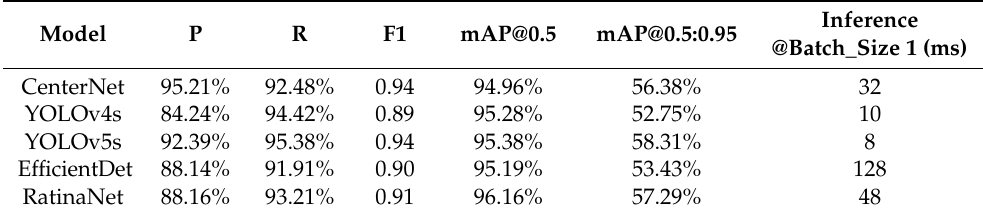
Table 3. Different object detection models based on standard boxes, among which YOLOv5s and CenterNet have outstanding performance, outperforming the other networks in terms of speed and